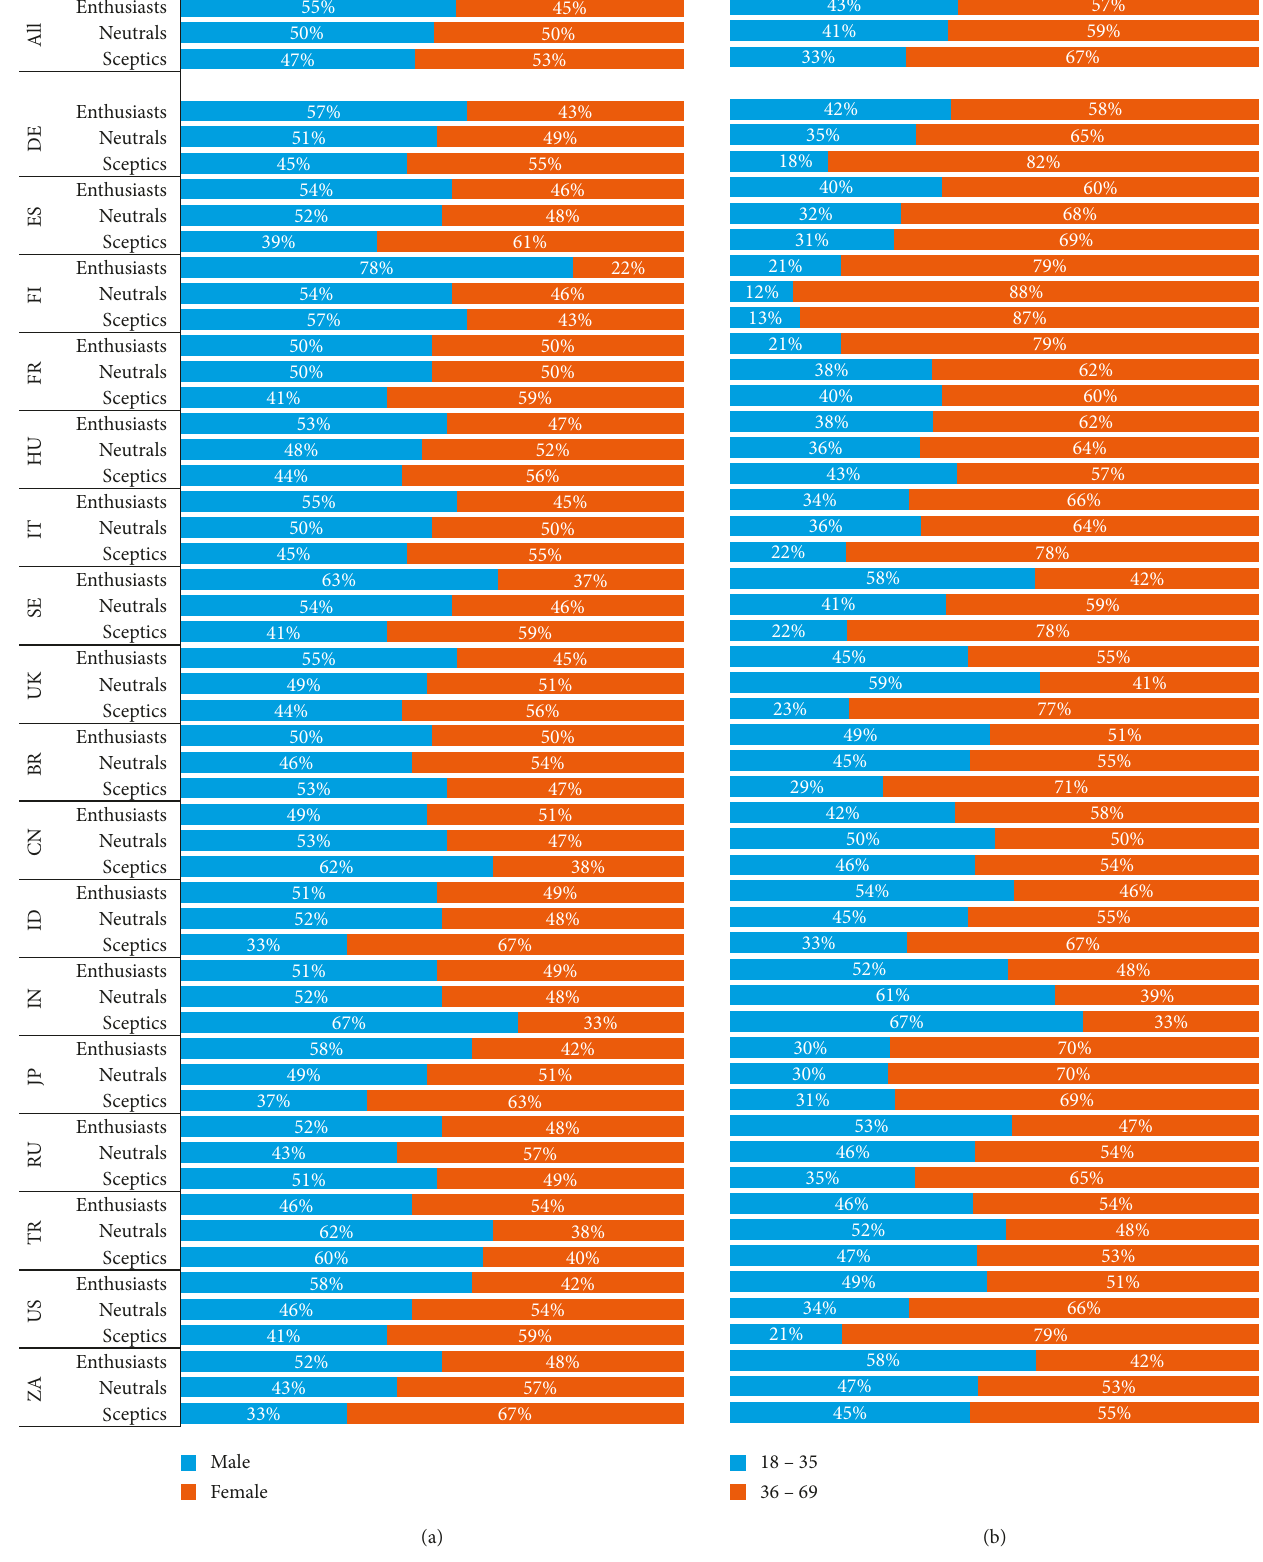
Figure 2: (a) Percentage values of Enthusiasts, Neutrals, and Sceptics differing in gender. (b) Percentage values of Enthusiasts, Neutrals, and Sceptics differing in age. Note that the age categories 1 (18–22) and 2 (23–35) were merged into one age category, and 3 (36–55) and 4 (56–69) were merged into a separate age category,